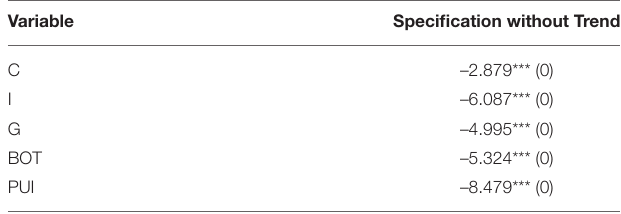
TABLE 3 | Cross-sectional augmented Im–Pesaran–Shin (CIPS) test of Pesaran